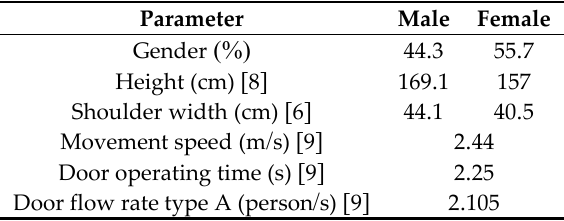
Table 3. Parameter which determined in Pathfinder